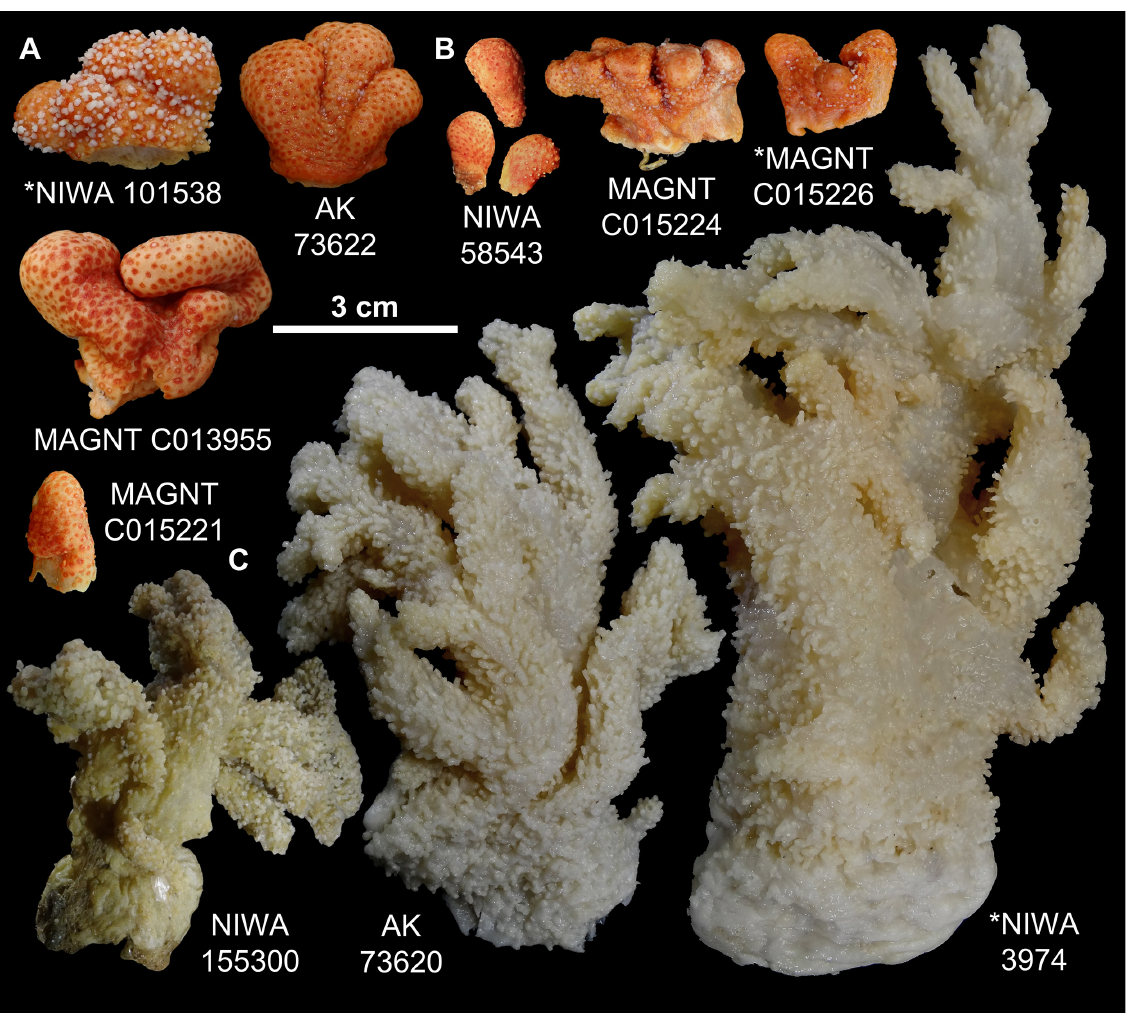
Fig. 14. Preserved specimens. A . Kotatea kurakootingotingo gen. et sp. nov. B . K. niwa gen. et sp. nov. C . K. kapotaiora gen. et sp. nov. Note that MAGNT C015224 and NIWA 58543 contain additional fragments that are not depicted. * =